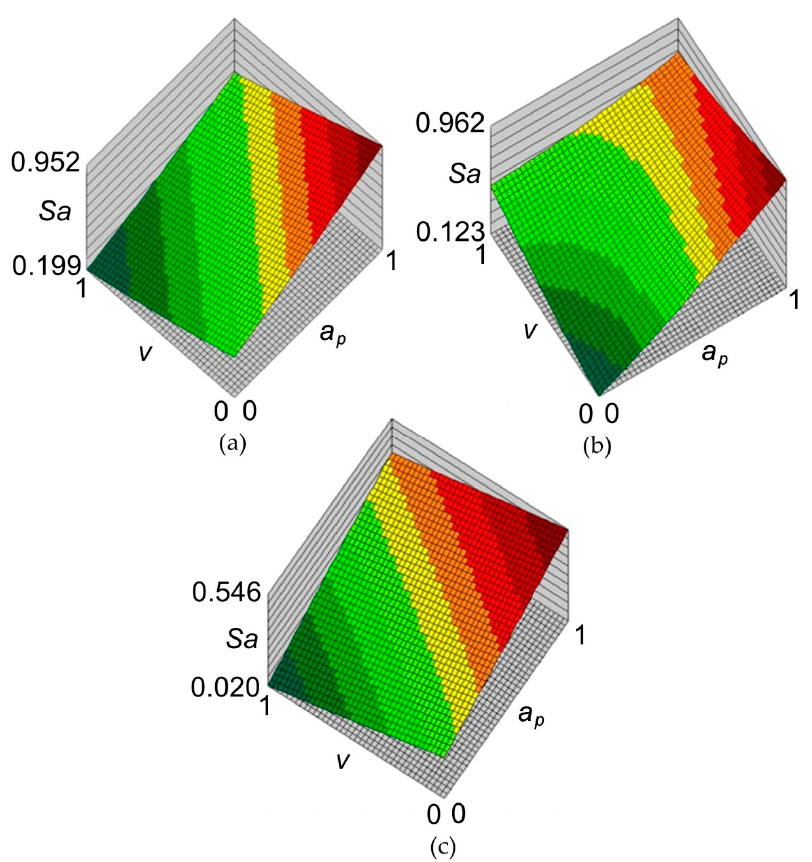
Figure 8. Response surfaces of the neural network 2:2-8-1:1 concerning the influence of incremental vertical step size a p and the tool rotational speed v on the value of the average roughness Sa (normalised data) for sheets: ( a ) 0.4-mm-thick EN AW-2024-T3 Alclad, ( b ) 1-mm-thick EN AW-2024-T3 and ( c ) 0.8-mm-thick EN AW-7075-T6